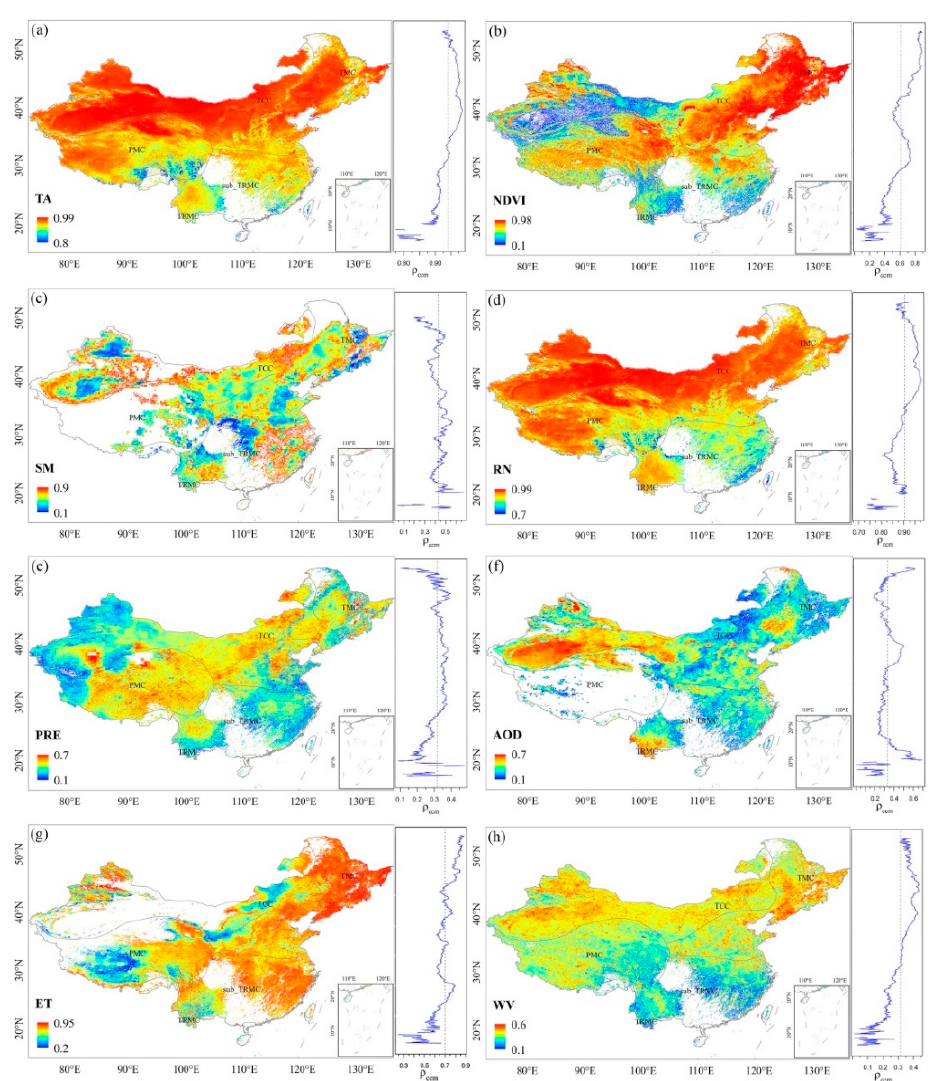
Figure 8. Spatial and latitudinal distribution of ρ ccm between LST and each environmental factor based on the CCM and the SST methods. ( a ) TA ( b ) NDVI ( c ) SM ( d ) RN ( e ) PRE ( f ) AOD ( g ) ET ( h ) WV. Blank areas in spatial distribution figure indicate invalid pixels.